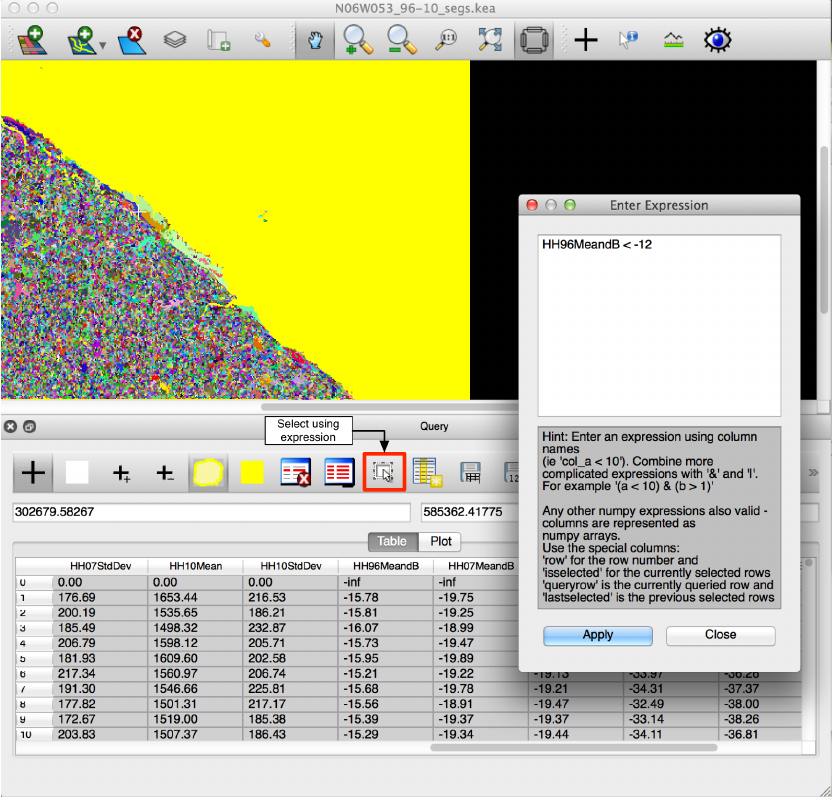
Figure 3. A screen shot showing how TuiView is used to interrogate the raster attribute table (RAT) through the “Select using Expression” tool to interactively define thresholds for a rule-based